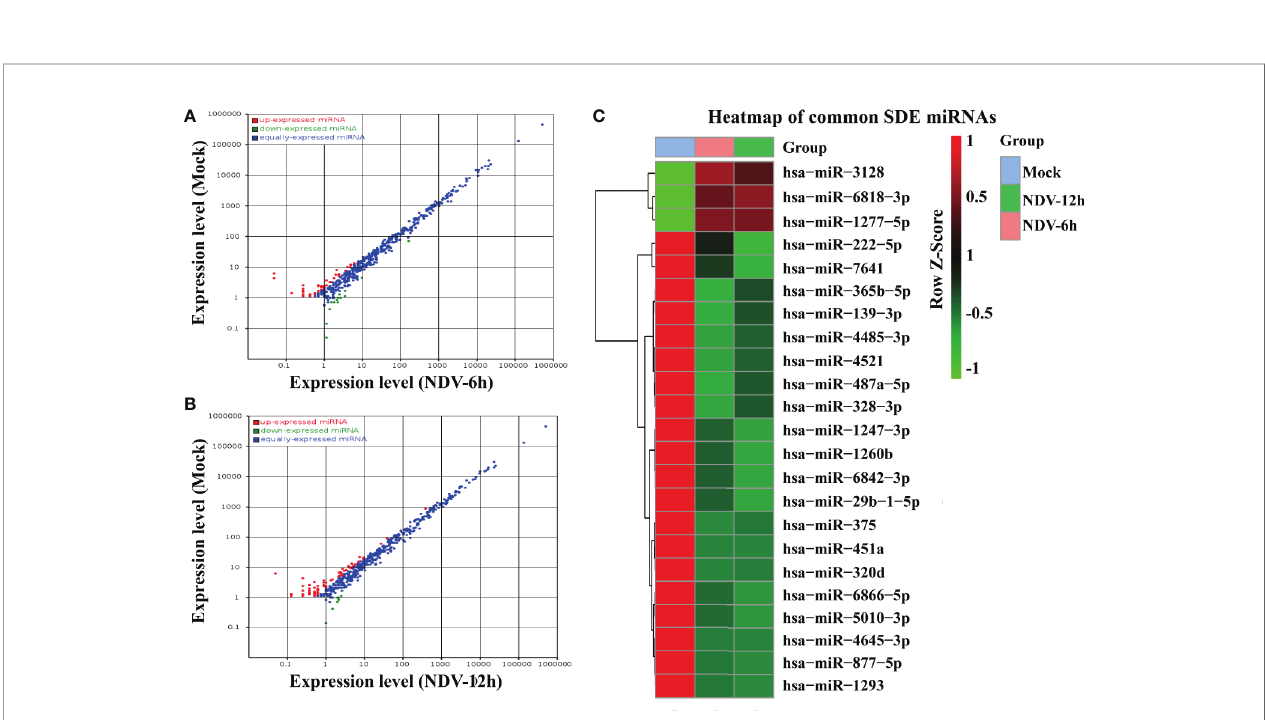
FIGURE 3 | Comparison of the SDE miRNAs between NDV-infected and -uninfected HeLa cells. The scatter plot of SDE miRNAs of two comparable groups: (A) NDV-6h vs . Mock and (B) NDV-12h vs . Mock. (C) The heat map of 23 common SDE miRNAs in two comparable groups. The expression index with the ROW Z- Score is on the right representing degree of abundance in each group. Red shaded areas indicate higher expression, whereas green shaded areas indicate lower expression and black denotes the relatively similar expression between NDV-infected and -uninfected groups.